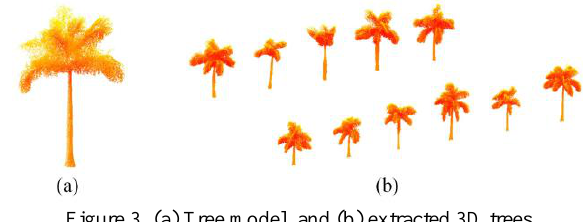
Figure 3. (a) Tree model, and (b) extracted 3D trees.